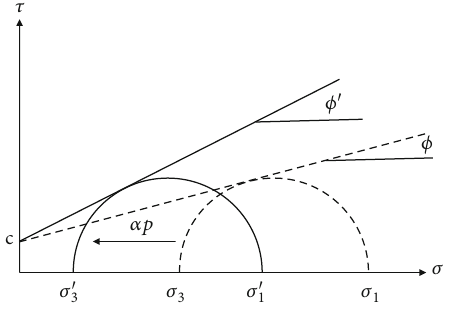
Figure 12: Mohr-Coulomb